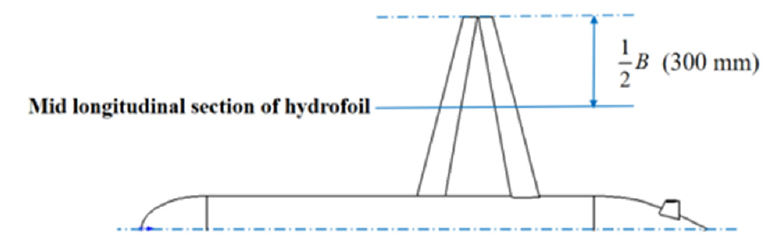
Figure 11. The hydrofoil profile in the longitudinal section in the center plane.